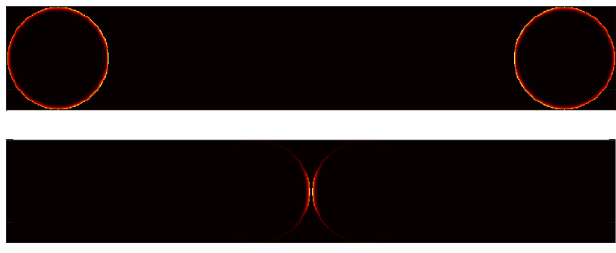
Figure 7: Normalized current distribution at 𝜁 = 40.0